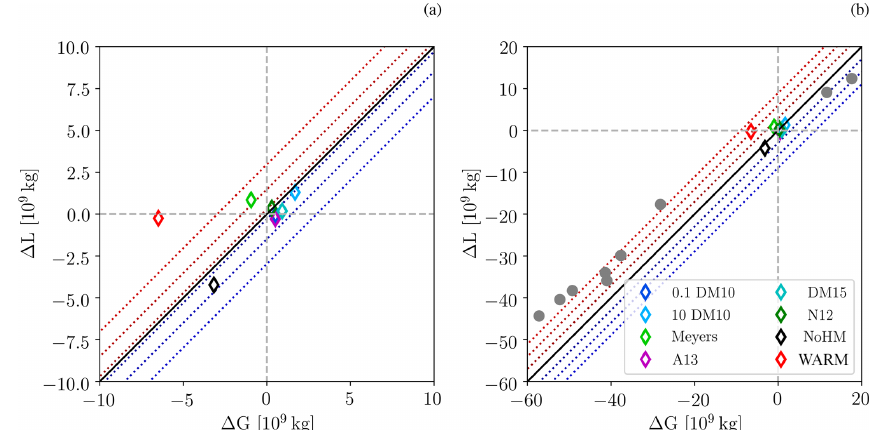
Figure 5. Scatterplot of change in condensate gain (cid:49)G and condensate loss (cid:49)L relative to the simulation with the DeMott et al. (2010) heterogeneous freezing parameterization and a representation of the Hallett–Mossop process (baseline simulation). The condensate gain in the baseline simulation is 137 . 0 × 10 9 kg, and the condensate loss is 107 . 3 × 10 9 kg. The grey symbols in panel (b) represent the nine mete- orological ensemble members other than the baseline simulation. The blue and red dashed lines indicate relative changes in precipitation of 0.1%, 5%, and 10% in panel (a) and 10%, 20%, and 30% in panel (b) .